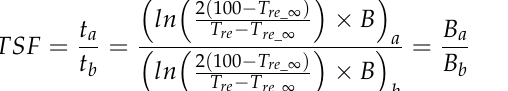
Table 17. Values of 𝐸 (cid:3028) 𝑅⁄ (G2) based on the fourth prediction model. 𝑻 (%) 𝑬 𝒓𝒆